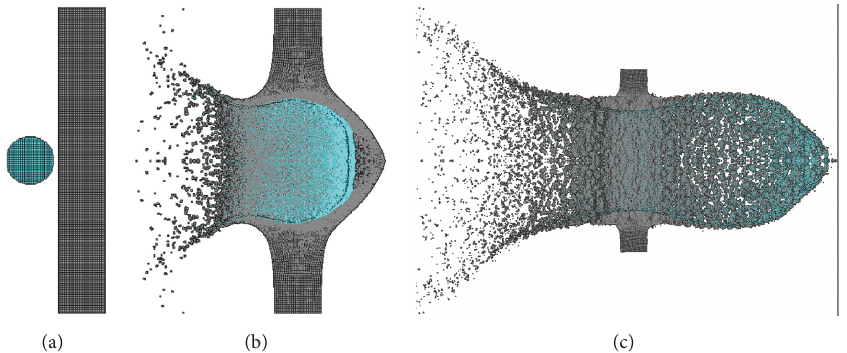
Figure 7: Impact of an aluminum projectile on an aluminum bumper: (a) 𝑡 = 0 ; (b) 𝑡 = 0.55 𝜇 s; (c) 𝑡 = 2.20 𝜇